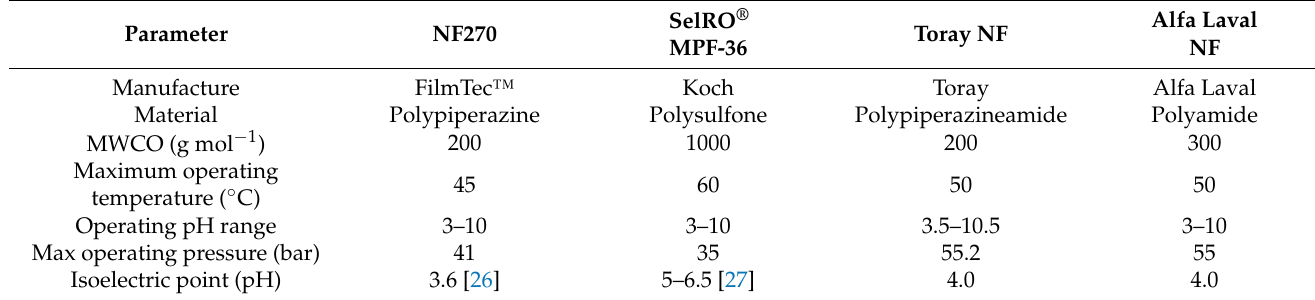
Table 2. Characteristics of the nanofiltration membranes.